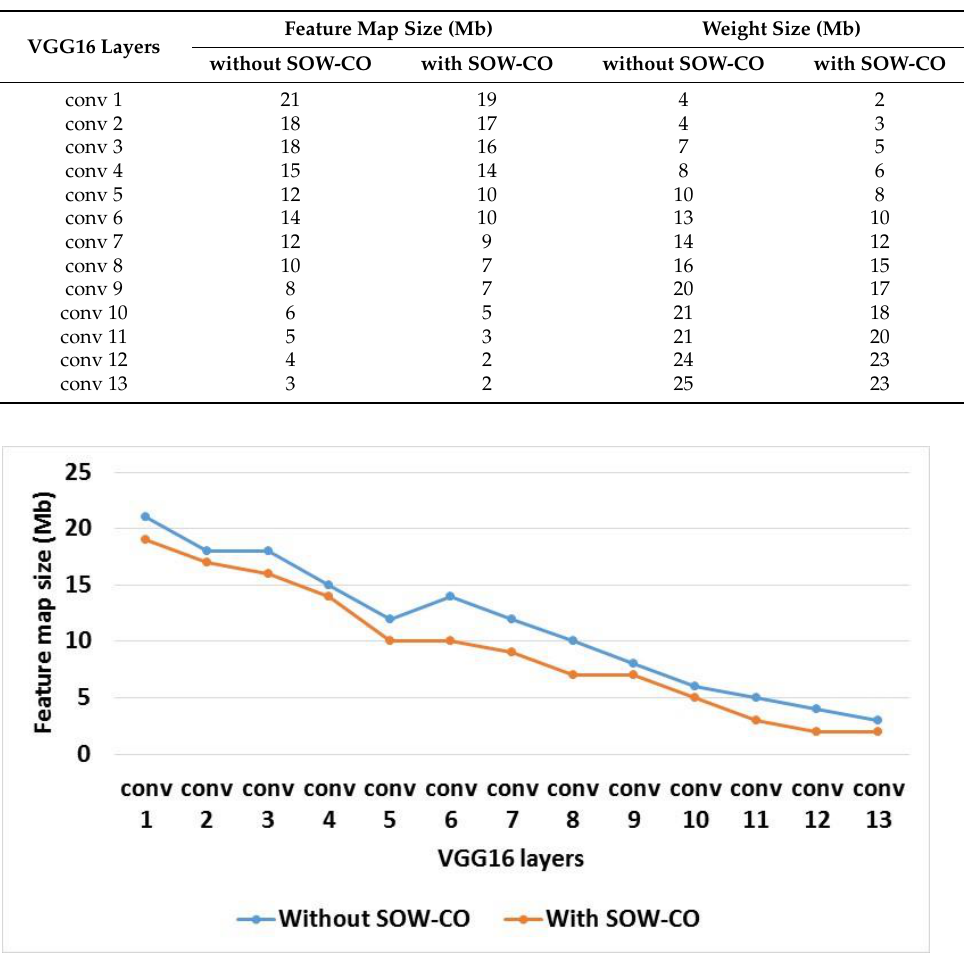
Figure 12. Graphical illustration of weight size for VGG16. The investigation of feature map and weight sizes for RCNN-VGG19 with and with- out SOW-CO is shown in Table 4. Figures 13 and 14 show the graphical illustrations of feature map and weight sizes, respectively. From the analysis, it is known that the feature map and weight sizes of RCNN-VGG19 with SOW-CO are less than the RCNN without SOW-CO. The utilization of sparse matrix in weight and convolutional optimization re- duces the sizes of the feature map and weight. Table 4. Analysis of feature map and weight sizes for VGG19. VGG19 Layers